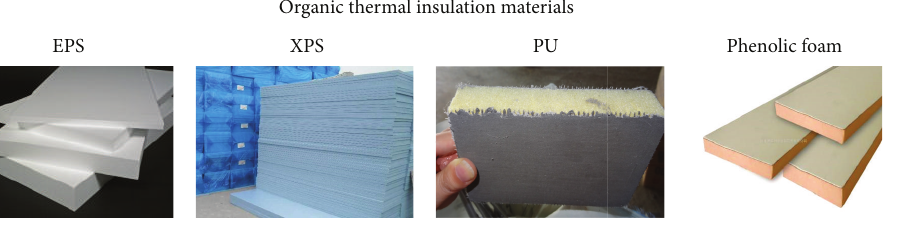
accompanied by heat transfer. In addition, the heat transfer between the materials themselves and the surrounding air is normally conducted through